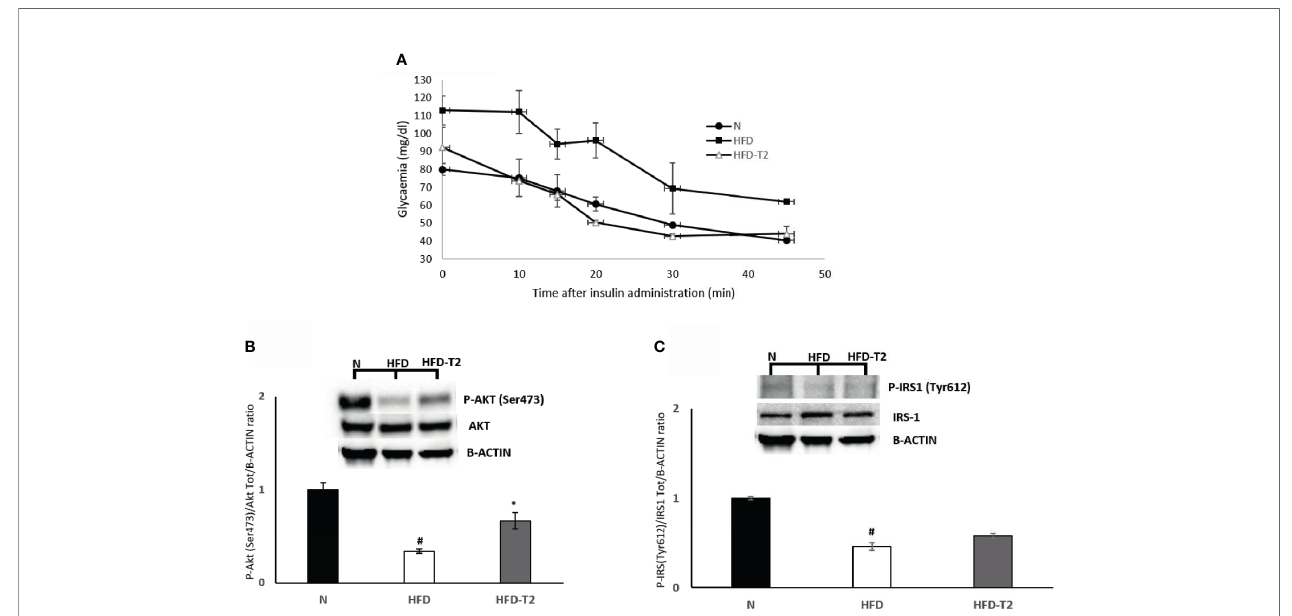
FIGURE 1 | Effects of T2 on insulin responsiveness. (A) Insulin Tolerance test (ITT). Glycemia after insulin administration at different time points in N, HFD, and HFD + T2 rats. Values are means ± SEM of fi ve independent experiments (n = 5). (B, C) Western blot images and densitometry showing relative expression of two proteins involved in insulin signaling in vWAT. (B) Phospho AKT (Ser473) (C) Phospho IRS-1 (Tyr612); B-actin has been used as a loading control. Representative blots are shown. The histograms represent means ± SEM of fi ve independent experiments (n = 5), *P < 0.05 vs. HFD, # P < 0.05 vs. N. N: rats receiving a standard diet for 14 weeks; HFD: rats receiving a HFD for 14 weeks; HFD-T2: rats receiving a HFD for 14 weeks with a daily administration of T2 during the last 4 weeks.